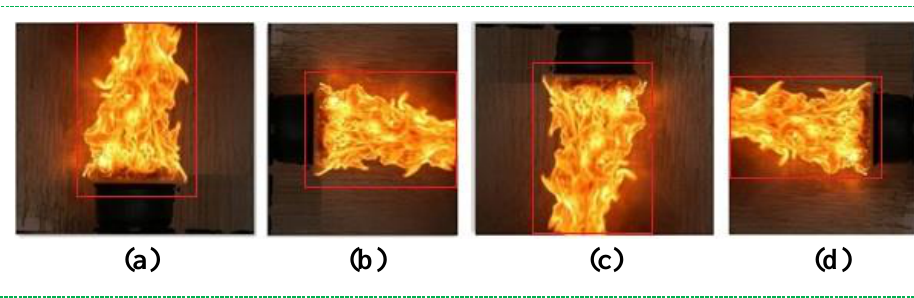
Figure 2. ( a ) Original image; ( b ) 90 ◦ rotation of ( a ); ( c ) 180 ◦ rotation of ( a ), and ( d ) 270 ◦ rotation of ( a Figure 2. Original image (a); 90 ° rotation (b); 180 ° rotation (c); 270 ° rotation (d).